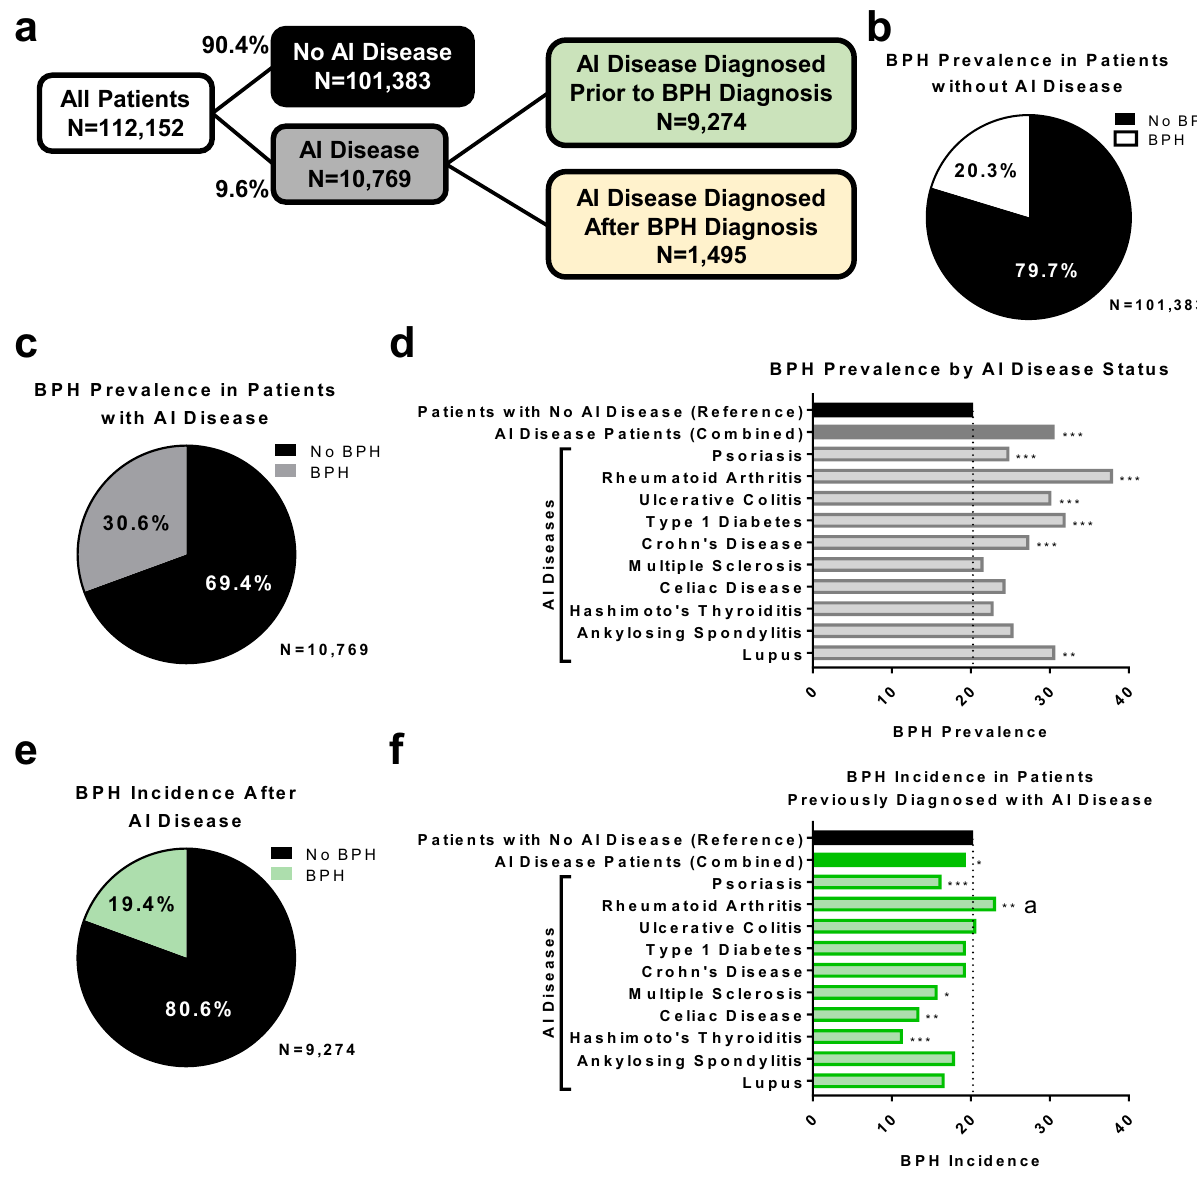
Fig. 1 Men with autoimmune disease have increased BPH prevalence. Chi-square tests were utilized to compare the proportion of BPH diagnoses in men with an AI condition versus men with no AI condition. Colors indicate categories of patients, where black = patients without AI disease, gray = patients with AI disease, green = patients diagnosed with AI disease prior to BPH diagnosis, and yellow = patients diagnosed with AI disease after BPH diagnosis. a Flow chart indicating the breakdown of patients into groups based on the presence of AI disease diagnosis (9.6% with and 90.4% without AI disease diagnosis). Patients with AI disease diagnosis were further separated into groups based on whether AI disease diagnosis occurred prior to or after BPH diagnosis. b BPH prevalence in patients without AI disease is 20.3%. c BPH prevalence in patients with AI disease is 30.6%. d Graph indicates the signi fi cant increase in BPH prevalence in patients with different AI diseases compared to patients without AI disease using chi-square tests. e The BPH incidence in patients previously diagnosed with AI conditions, when patients may have been treated for these conditions, is 19.4%. f Chi-square tests indicate the signi fi cant changes in BPH incidence in patients diagnosed with different AI diseases prior to BPH diagnosis compared to the baseline BPH prevalence of 20.3%. a indicates a signi fi cantly higher BPH incidence than the 20.3% reference, although this is decreased from 38.0% prevalence in all RA patients (d). * p < 0.05, ** p < 0.01, and *** p < therapeutics, namely TNF-antagonists but not methotrexate, indicates that methotrexate use signi fi cantly increases BPH signi fi cantly decreased (odds ratio = 0.79; p = 0.033) the like- diagnosis ( p < 0.0001) while the use of TNF-antagonists sig- lihood of a BPH diagnosis compared to patients not taking these ni fi cantly decreases BPH diagnosis ( p = 0.006) compared to drugs (Table 1). In the AI disease patient population, the vast patients without AI disease (Supplementary Table 9). Since majority of patients were taking either methotrexate or TNF- patients with AI disease have an elevated BPH prevalence com- antagonists, with differences depending on the speci fi c AI disease pared to patients without AI disease, a similar comparison of the (Supplementary Table 8). Further evaluation of these drugs using BPH incidence in patients taking methotrexate or TNF- chi-square or Fisher ’ s exact tests in patients with AI disease antagonists to that of patients not taking medication within